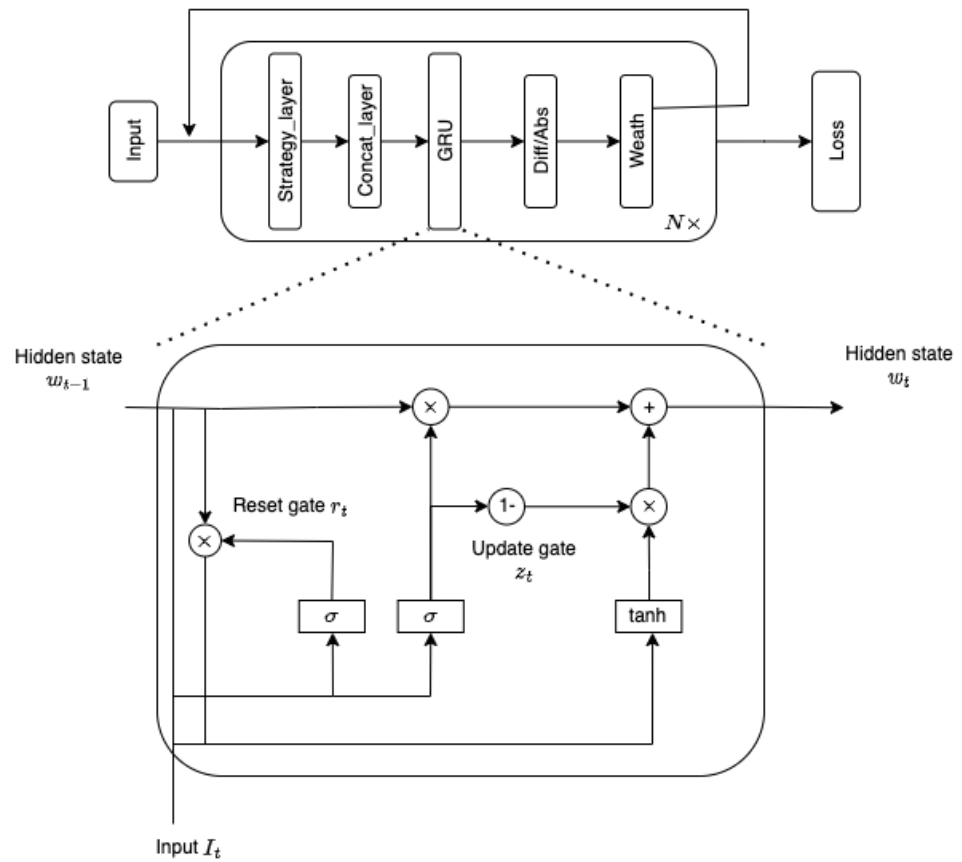
Figure 1. GRU–NN architecture for the deep